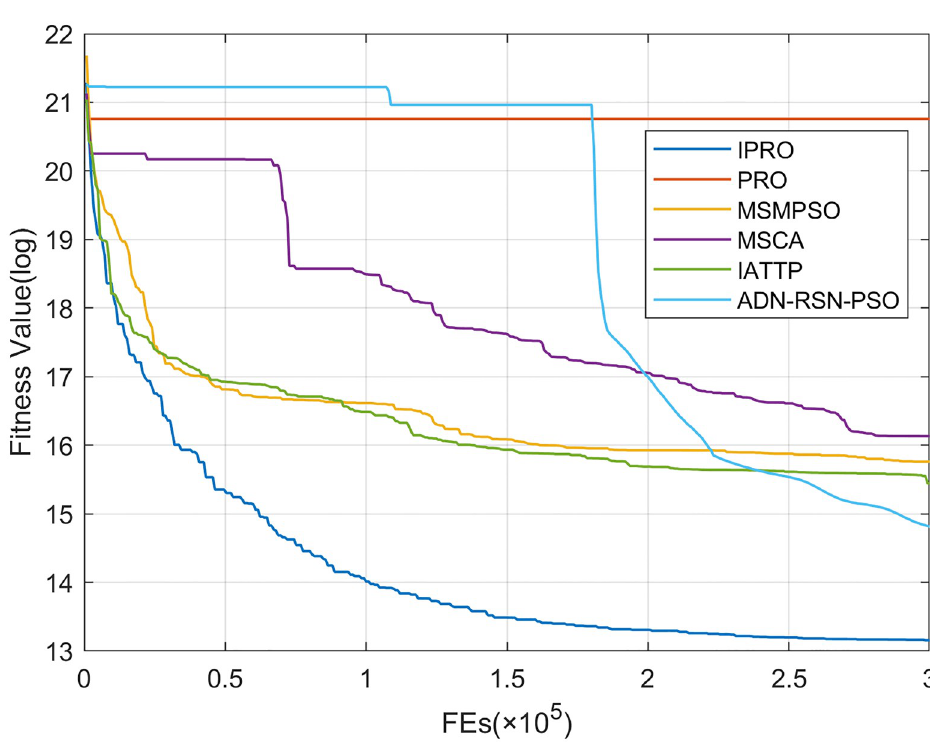
Fig 2. Convergence curves on